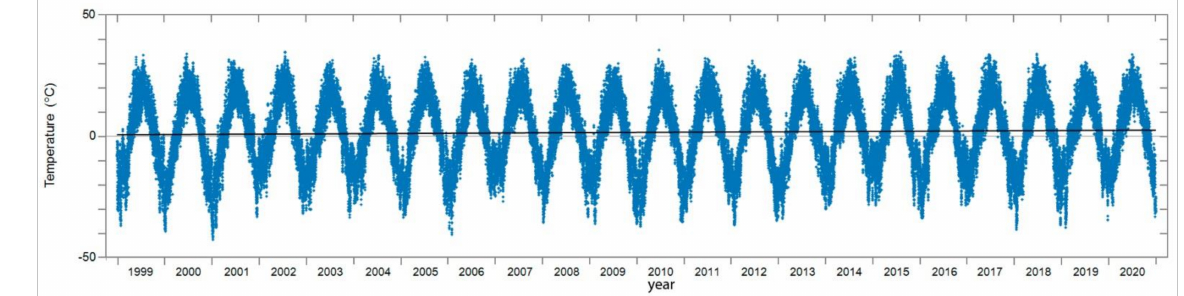
Figure 7. Surface temperature time series at IRKM. The black line is the linear trend.